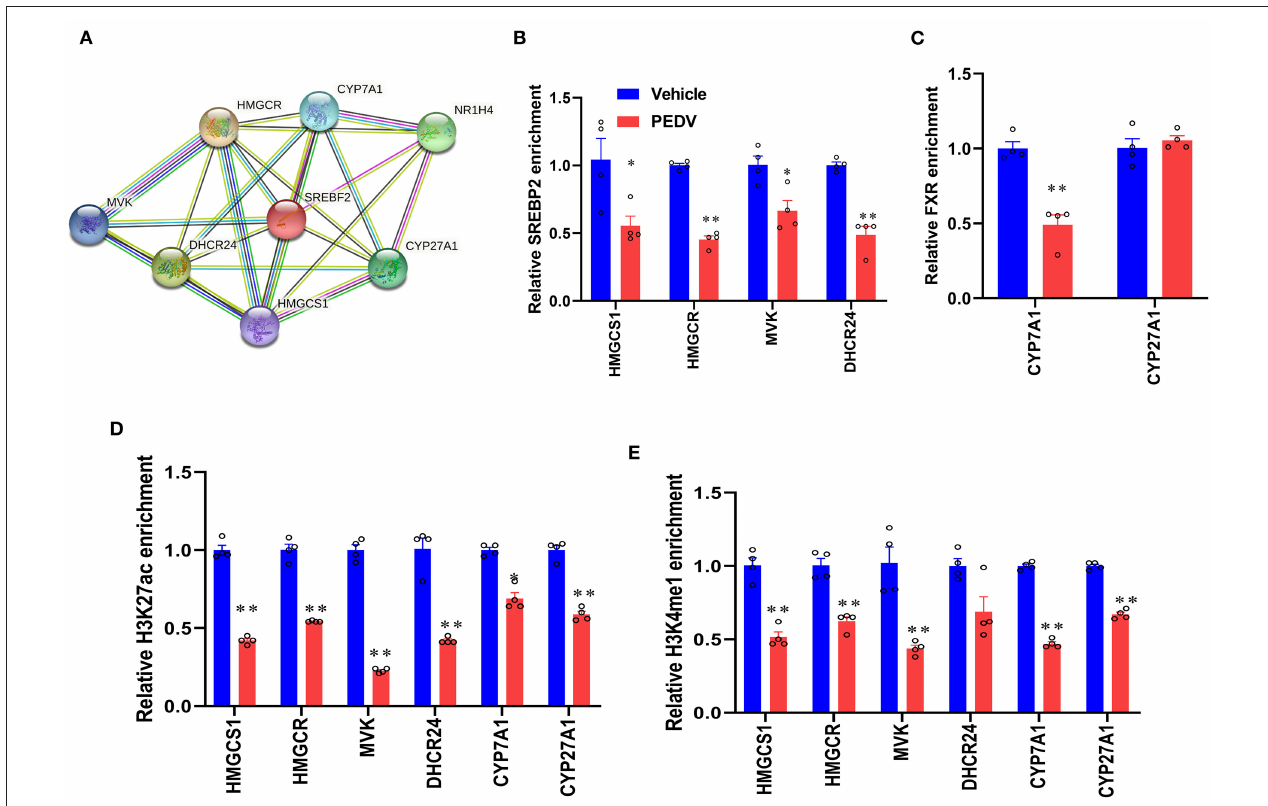
FIGURE 7 | PEDV infection epigenetically inhibited the transcriptional activation of gene expression by SREBP2 and FXR. (A) The interactions among SREBP2, FXR, and core proteins involved in cholesterol metabolism during transcriptional regulation were predicted by Search Tool for the Retrieval of Interacting Genes (STRING). (B,C) The relative enrichment of SREBP2 and FXR at the locus of indicated genes in livers was analyzed by ChIP-qPCR. (D,E) The relative enrichment of histone H3K27ac and H3K4me1 occupancy was analyzed by ChIP-qPCR. The data are shown as the means ± SEM, * P < 0.05, ** P < 0.01 using the two-tailed Student t